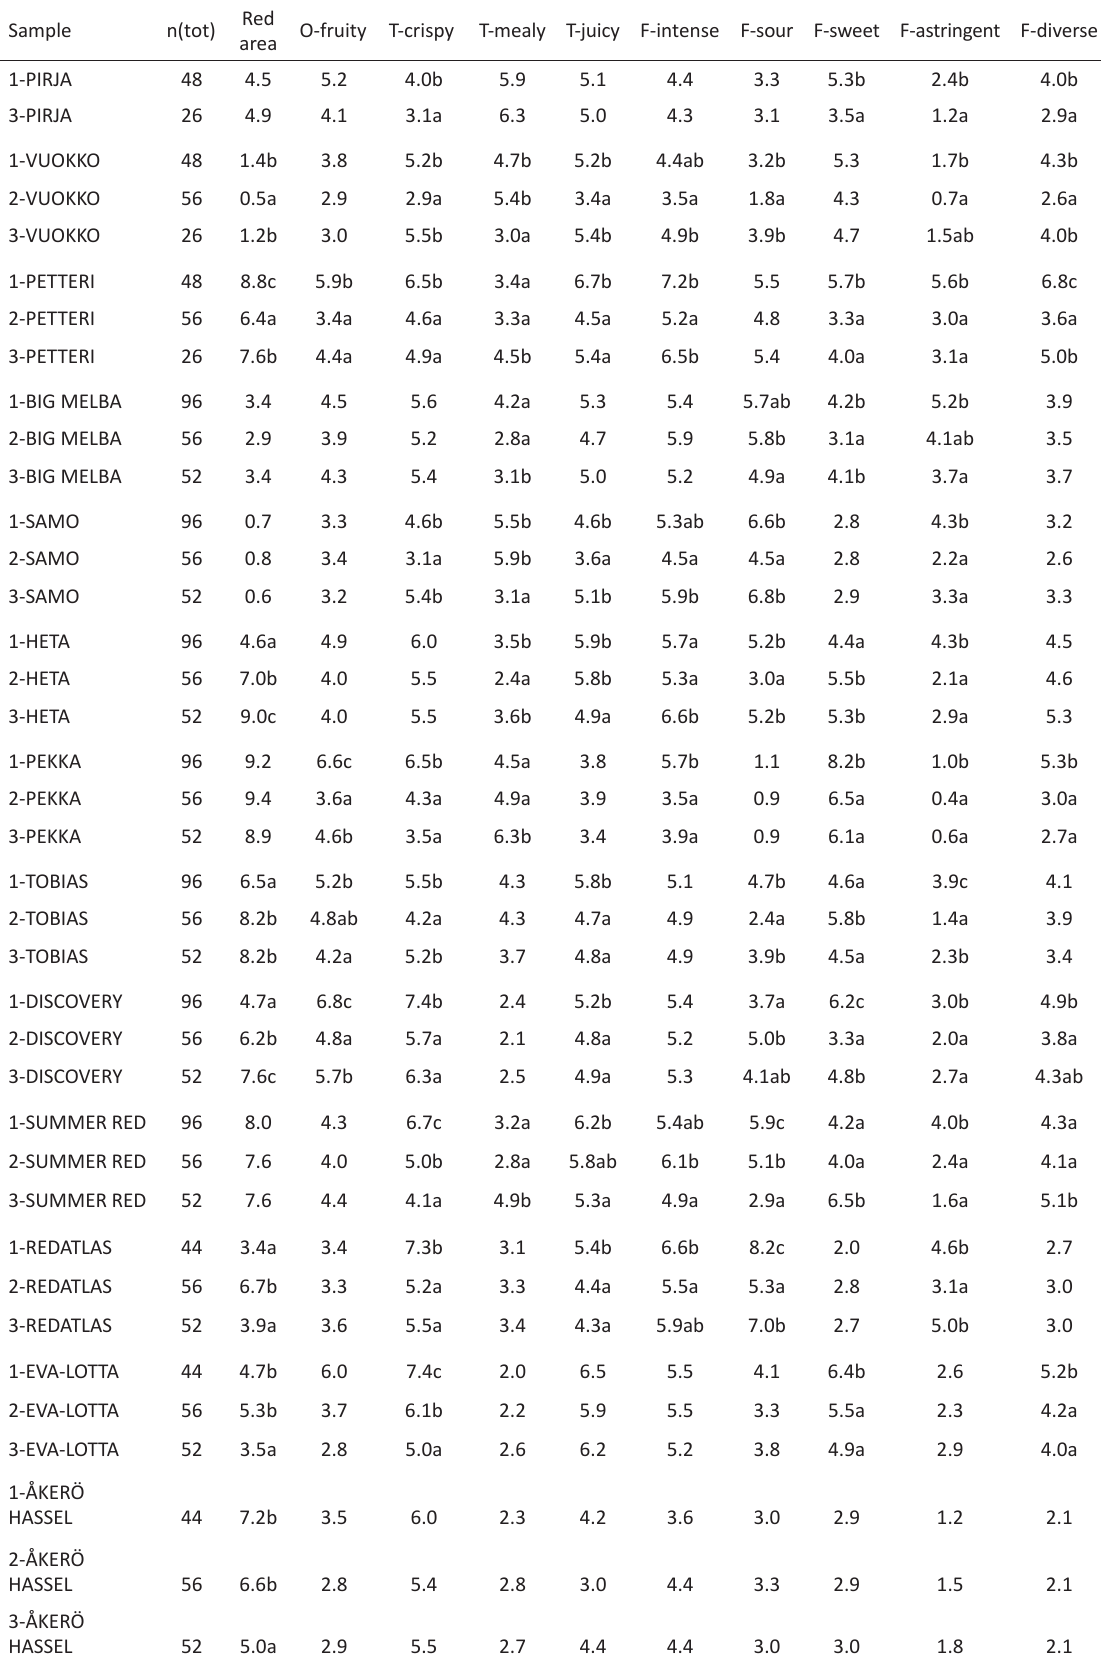
S3. Attribute intensity mean ratings in descriptive analysis of each cultivar during the three harvest years. The number before the cultivar name denotes the harvest year, 1 = 2009, 2 = 2010 and 3 = 2011. Letters O, T and F denote odour, texture and flavour,